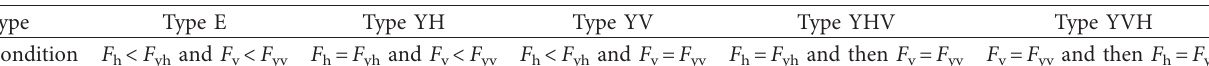
Figure 10: Algorithm for postyielding cases. Table 3: Calculation